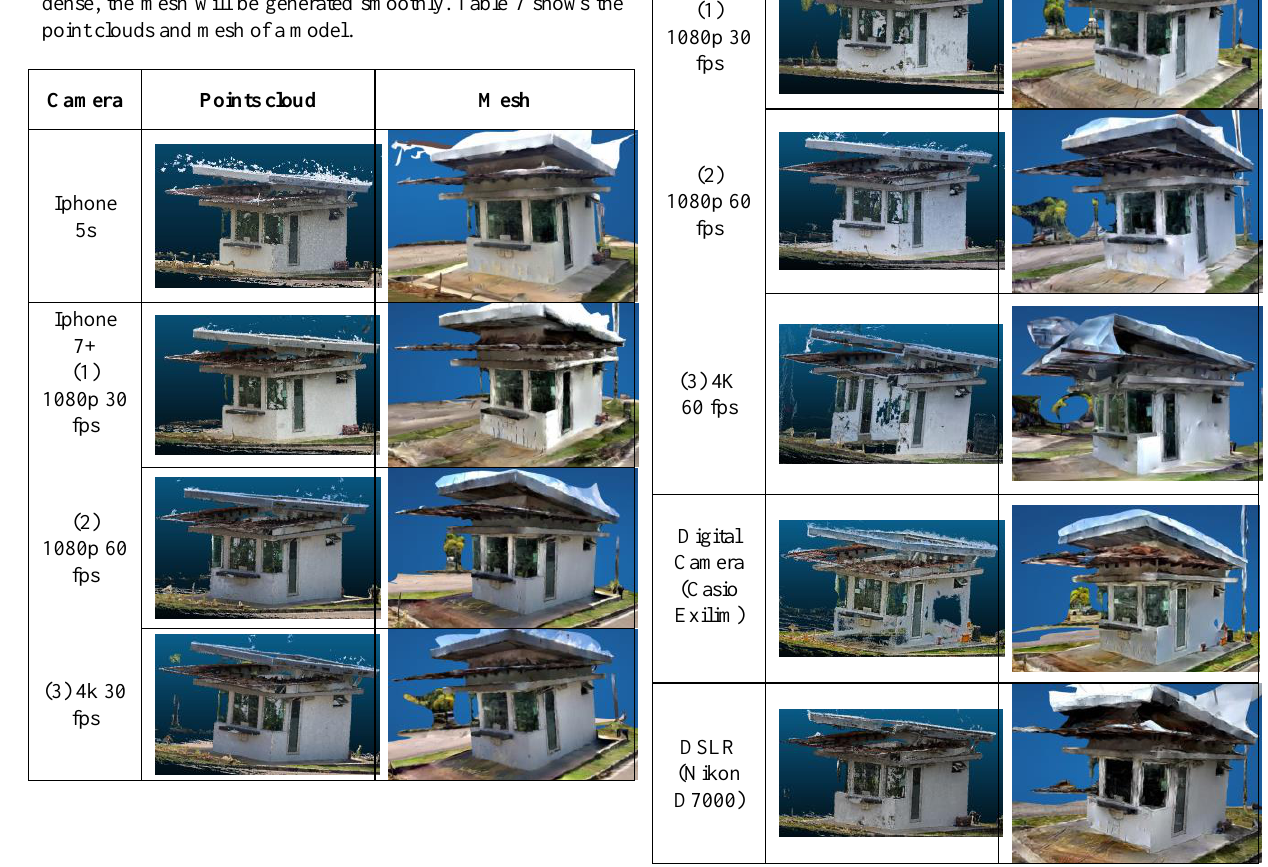
Table 7. Result of point clouds and